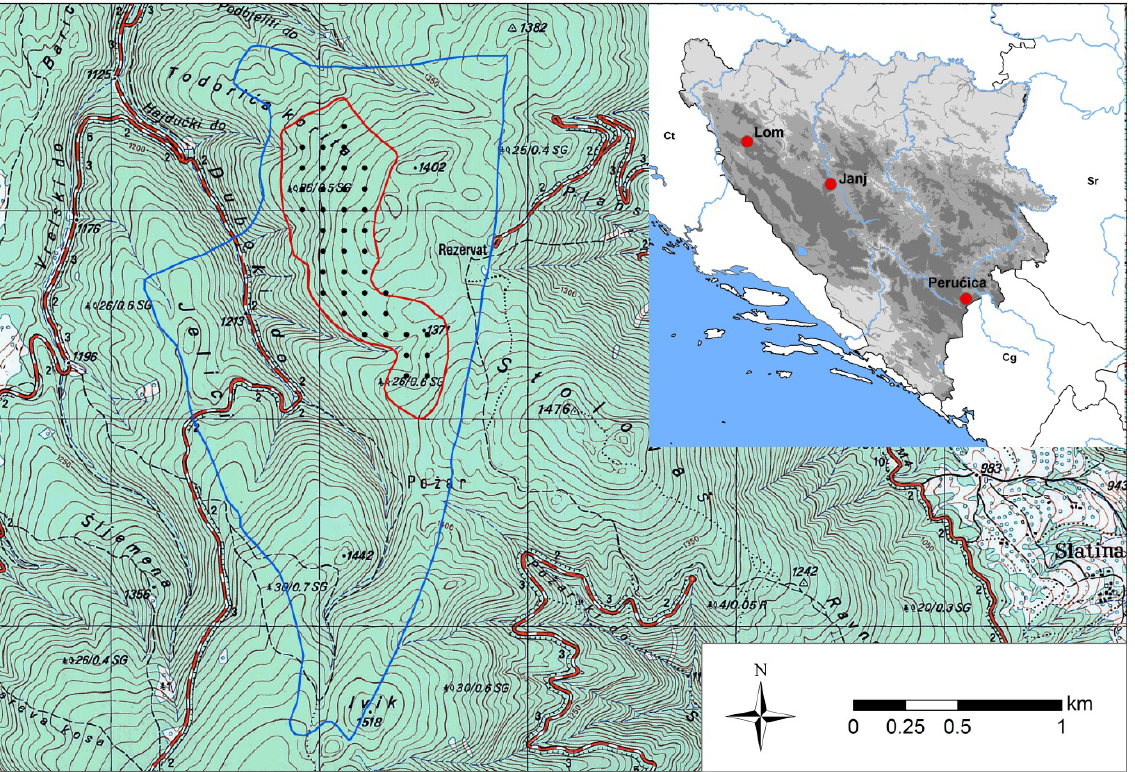
Figure 1. Geographic location, buffer zone and core area with research plot network in the Janj old-growth forest. The insertion at the upper right-hand side of the picture represents the location of the Lom, Janj and Perucica old-growth forests in Bosnia and